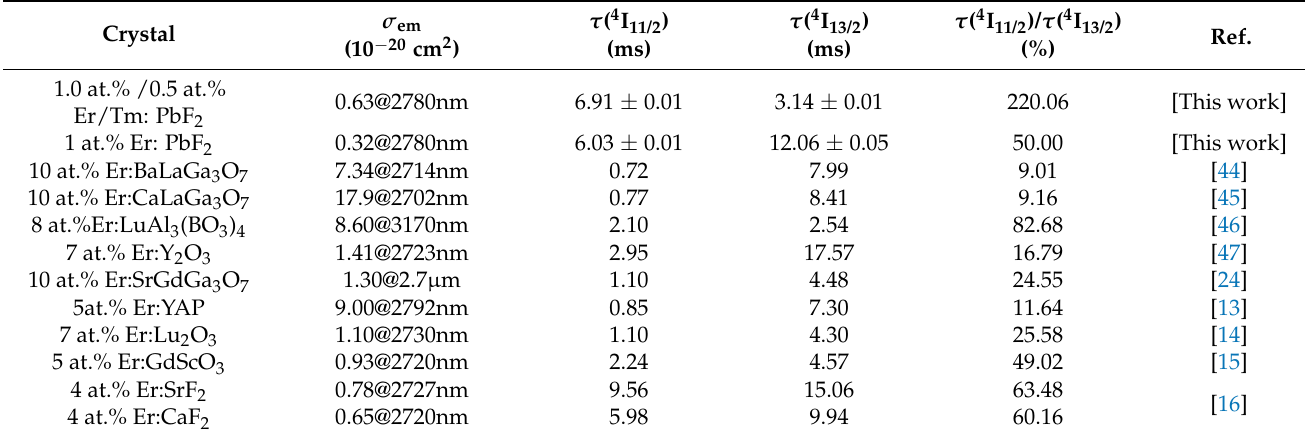
Table 1. MIR emission cross-sections σ em , and lifetimes of 4 I 11/2 , 4 I 13/ 2 levels of Er/Tm: PbF 2 , Er: PbF 2 crystals compared with other Er 3+ -doped crystals.